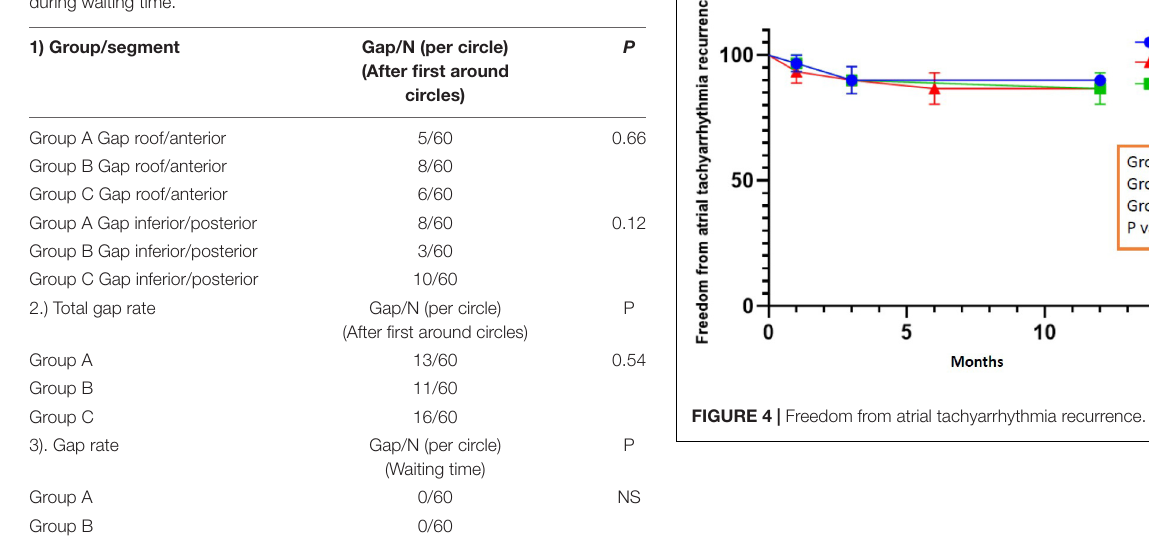
TABLE 3 | Comparison of gap rate after first-around ablation circles and during waiting time.